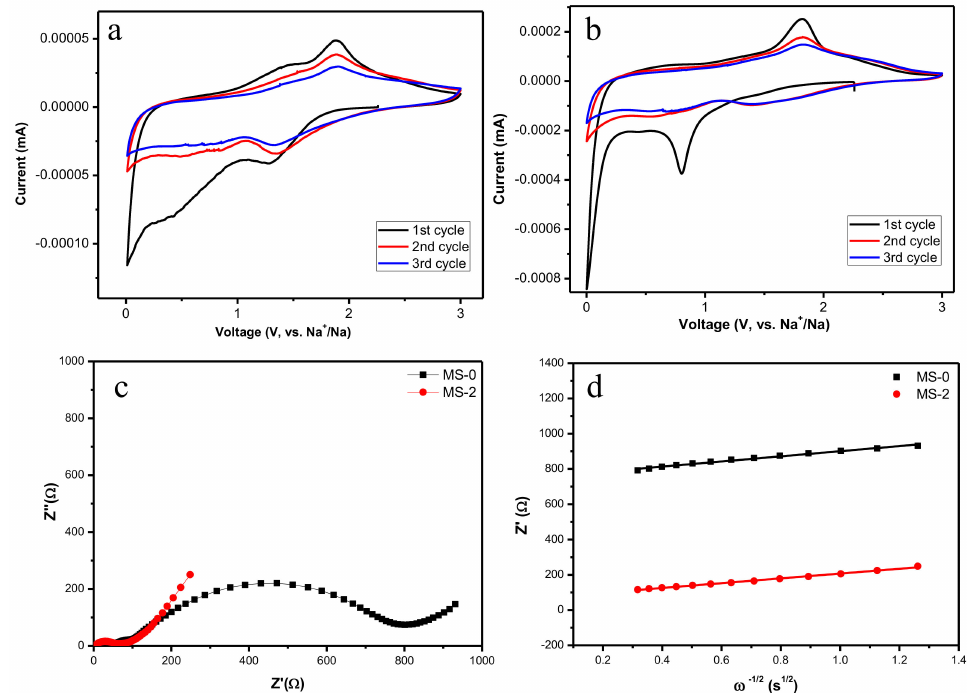
Figure 6. The first three consecutive CV curves of ( a ) MS-0 and ( b ) MS-2 at a scan rate of 0.1 mVs − 1 ( c ) Electrochemical impedance spectrum at OCV ( d ) The relationship between Zre and ω − 1/2